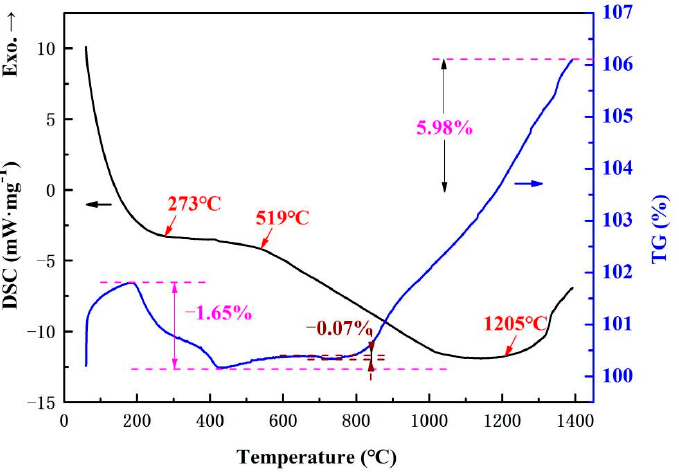
Figure 9. The backscattered electron image and EDS results of the surface of the ZrSi 2 -SiC coating containing 30 wt.% ZrSi 2 after oxidation at 1500 °C for 198 h. ( a ) SEM image; ( b , c ) EDS results.